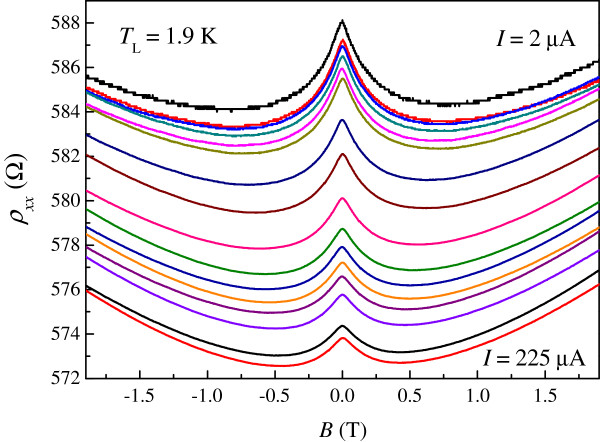
Magnetoresistivity measurements ρxx (B) at driving currents I. The lattice temperature is constantly fixed at T ≈ 1.9 K. From top to bottom: I = 2, 3, 5, 7, 8.5, 10, 20, 30, 50, 70, 85, 100, 125, 150, 200, and 225 μA, respectively.